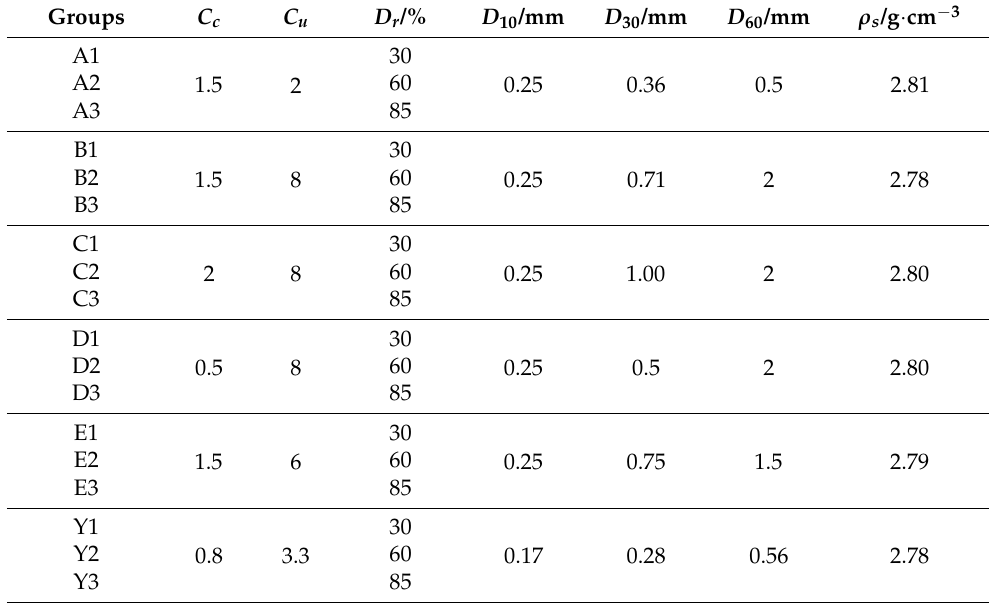
The experimental scheme and the physical parameters for various gradations of sand